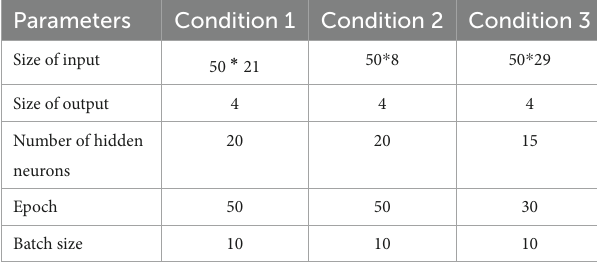
TABLE 2 Parameters setup for the first three